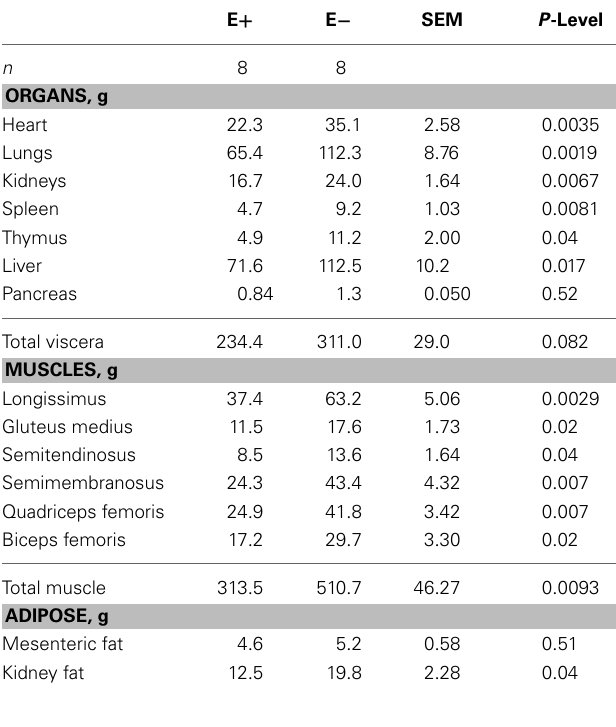
Table 4 | Proximate composition of total muscle mass from one